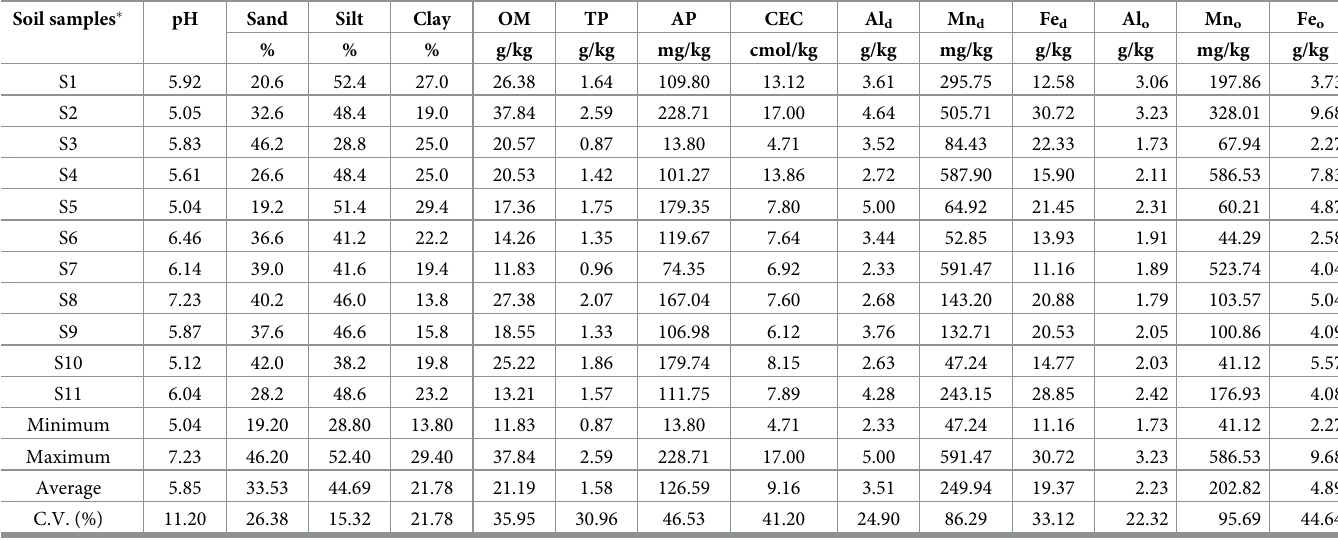
Table 3. Physico-chemical properties of the eleven soils from different vegetables fields (n = 11). Soil samples